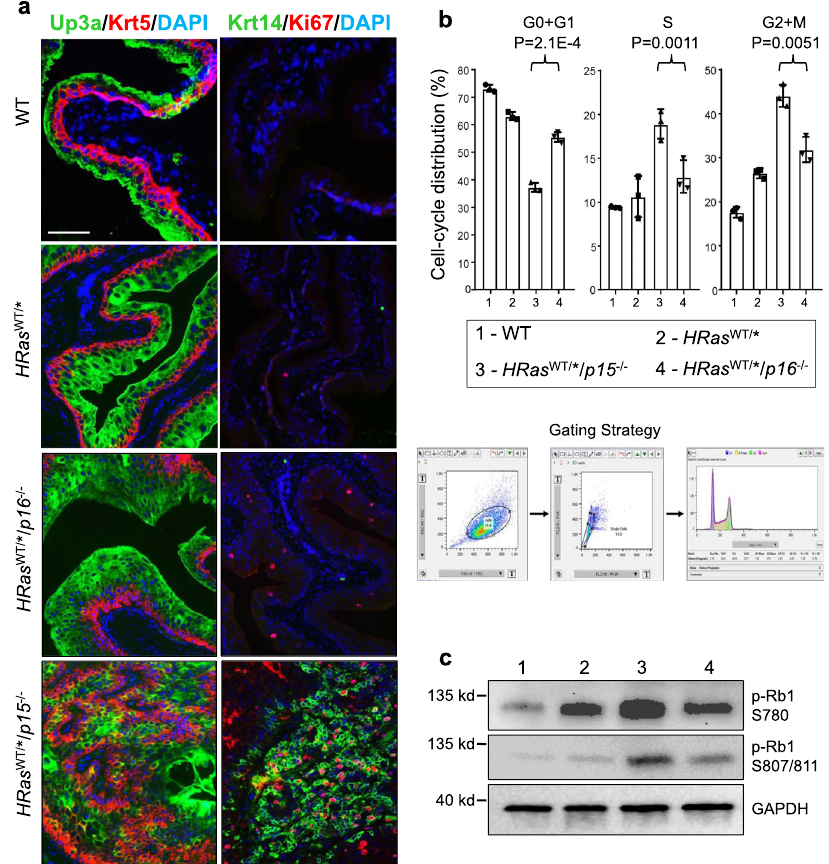
Fig. 3 Comparison of proliferative status of urothelia in age-matched (all 6 months) wild type (WT), HRas WT/* , HRas WT/* / p16 − / − , and HRas WT/* / p15 − / − mice. a Immuno fl uorescent staining of urothelial differentiation (Upk3a), proliferation (Ki67), and bladder cancer progenitor cell (Krt5 and Krt14) markers. Note the signi fi cantly greater Krt5, Krt14, and Ki67 positive urothelial cells in HRas WT/* / p15 − / − mice than in HRas WT/* / p16 − / − mice. n = 5 per genotype indicated on the left. The panels are of the same magni fi cation and the bar in the upper-left panel equals 50 μ m. b Cell-cycle distribution (3 mice/ genotype). Freshly stained urothelial cells by propidium iodine underwent (see Gating Strategy) (i) forward versus side scatter to remove small debris and large aggregates, (ii) width versus area to remove doublets, and (iii) cell-cycle distribution based on DNA content using FlowJo-embedded cell-cycle analysis. Data are presented as mean value ± SD. Two-sided t -tests were performed to compare the signi fi cance of the differences between the two groups (HRas WT/* /p15 − / − versus HRas WT/* /p16 − / − ). The P values are shown in the fi gure. Note that urothelial cells in S and G2 + M phases were 2 – 3-fold higher in HRas WT/* / p15 − / − mice than in HRas WT/* / p16 − / − mice. c Western blotting (1 mouse/lane) detection of phosphorylated pRb1. Source data are provided as a Source Data fi le. Note that the pRb1 phosphorylation (at both S780 and S807/811) was signi fi cantly higher in HRas WT/* / p15 − / − mice than in HRas WT/* / p16 − / −